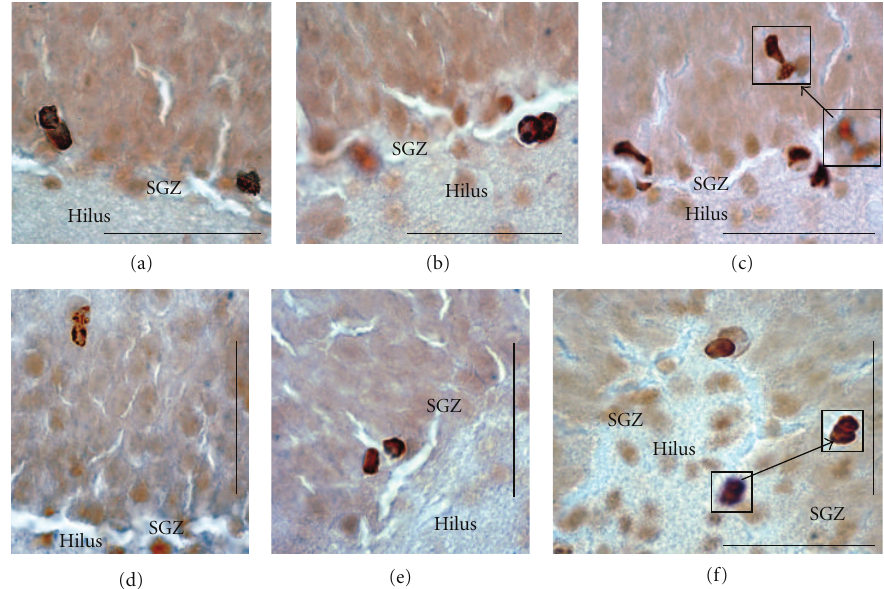
Figure 3: Light microscopic immunohistochemical demonstration of the BrdU-labelled doublets in DG as a result of apparent mitotic division of cells. Postmitotic BrdU immunoperoxidase-labelled cells in di ff erent zones of DG on coronal slices (50 μ m thick). (a–c) Localization of postmitotic cells near subgranular zone (SGZ). (d–f) Possible migration of postmitotic cells from SGZ (e) to supragranular zone of DG (d). (f) Because of the thickness of brain slices di ff erent BrdU-labelled cells are frequently located at various depths in the 50 μ m slice, in (f) (inset) the same cells can be seen at di ff erent focal planes. Scale bar = 50 μ